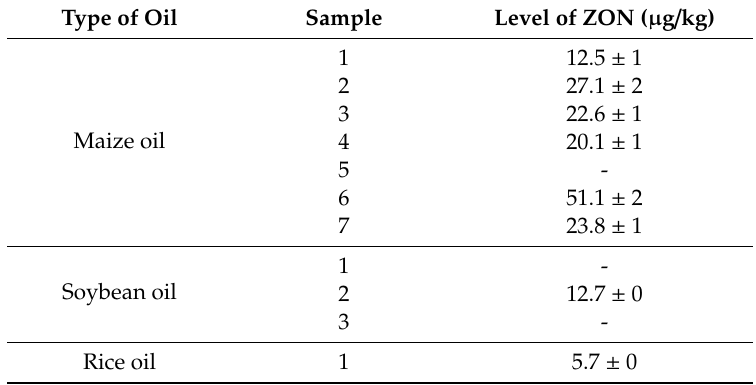
Table 3. Zearalenone content ( μ g/kg) of commercial oil samples purchased at local markets.